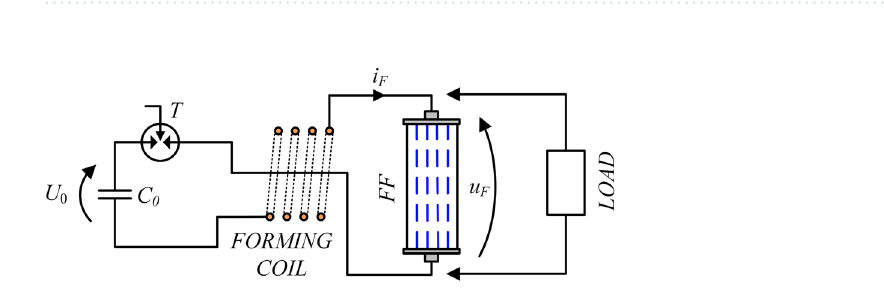
Figure 1. Block diagram of the high-power pulses cascade generation and forming system.